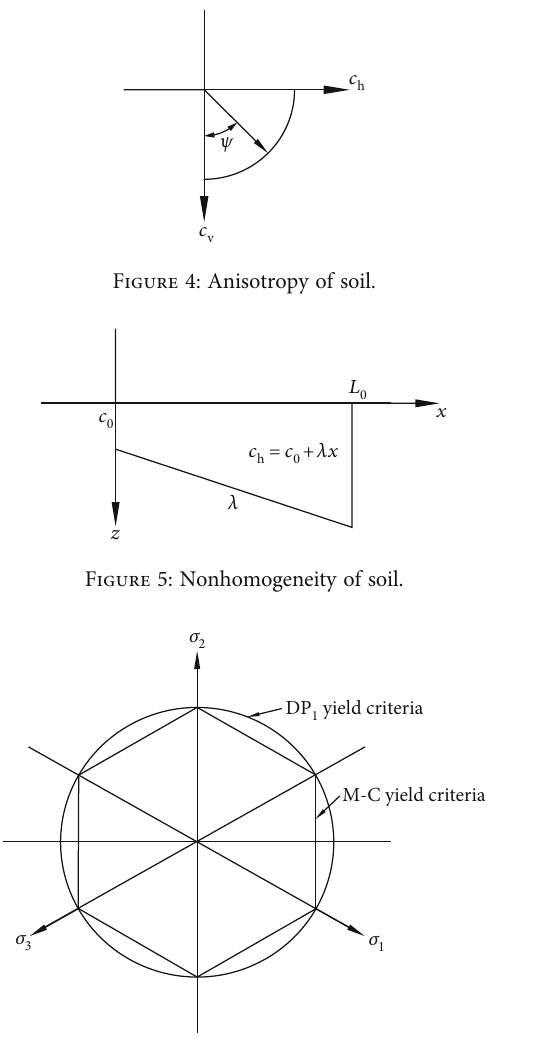
Figure 6: Yield curves of M-C and DP1 yield criteria in the π